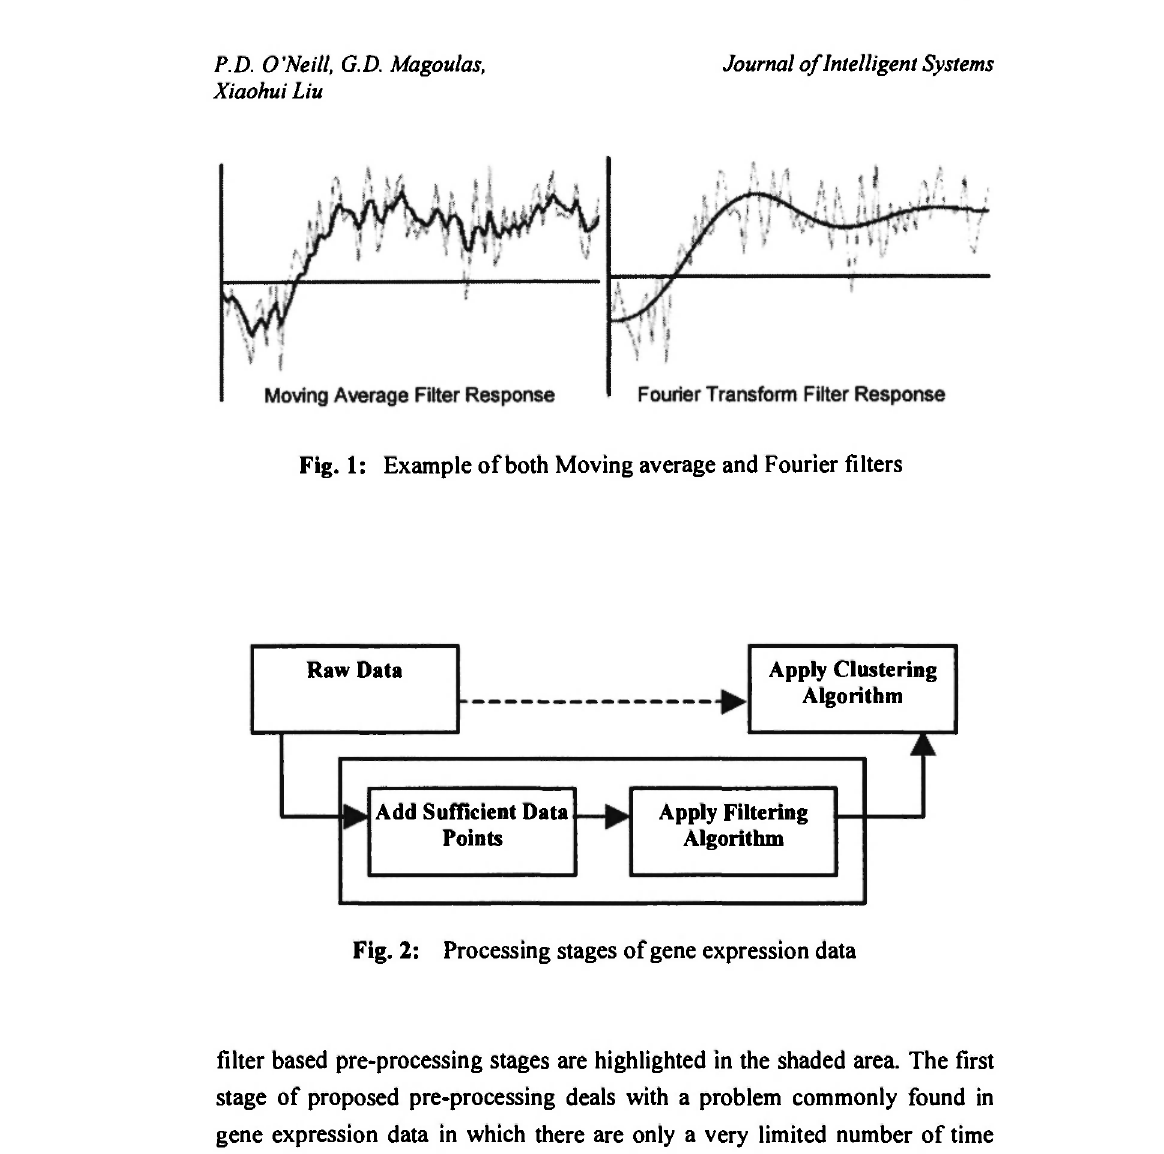
Fig. 2: Processing stages of gene expression